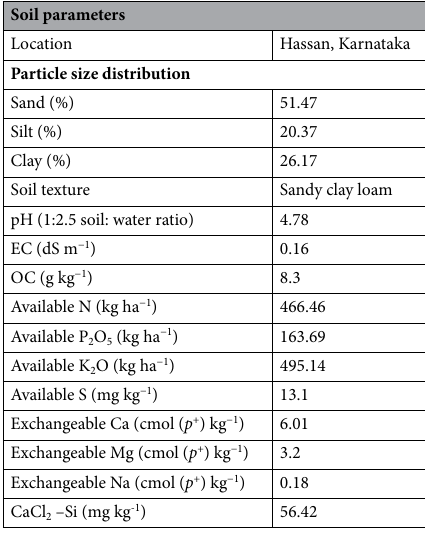
Table 5. Initial properties of soil used in this